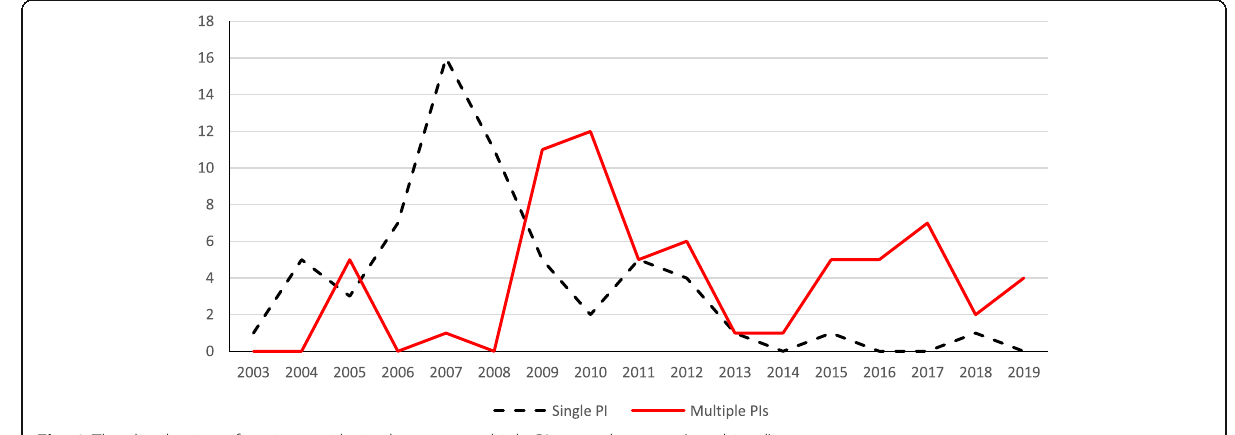
Fig. 8 The distribution of projects with single versus multiple PIs over the years